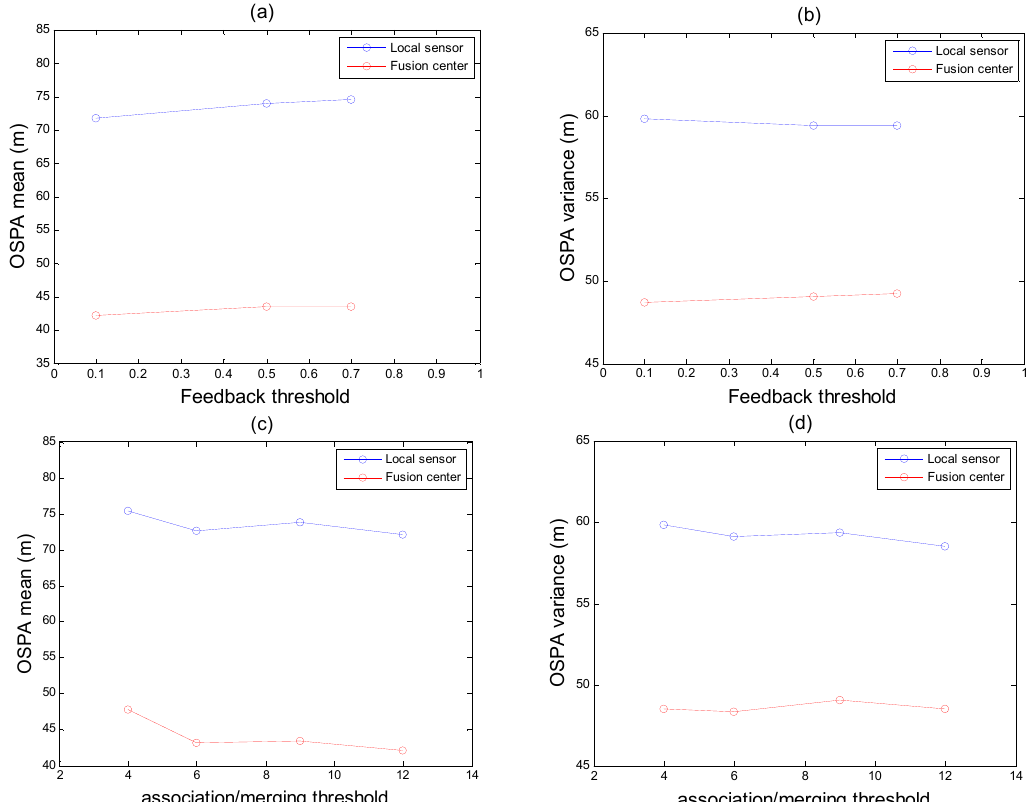
Figure 13. Simulation analysis of the effect of threshold on algorithm performance.